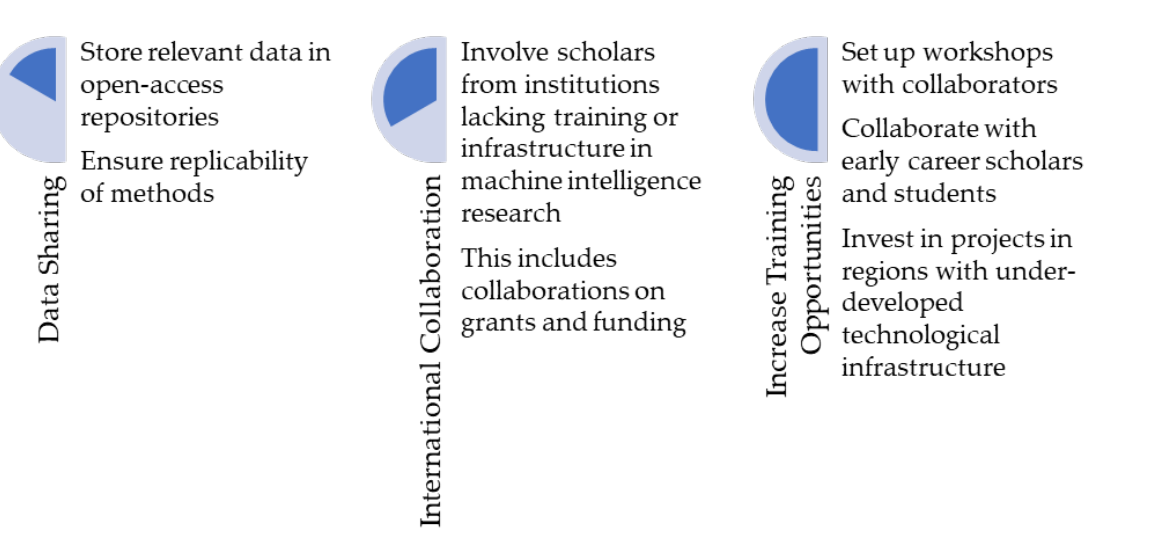
Figure 6. Graphical representation of the different steps necessary to address the geographic disparity in machine intelligence approaches within archaeology. Data sharing, while necessary, is not enough to decrease this widening gap in archaeological development.